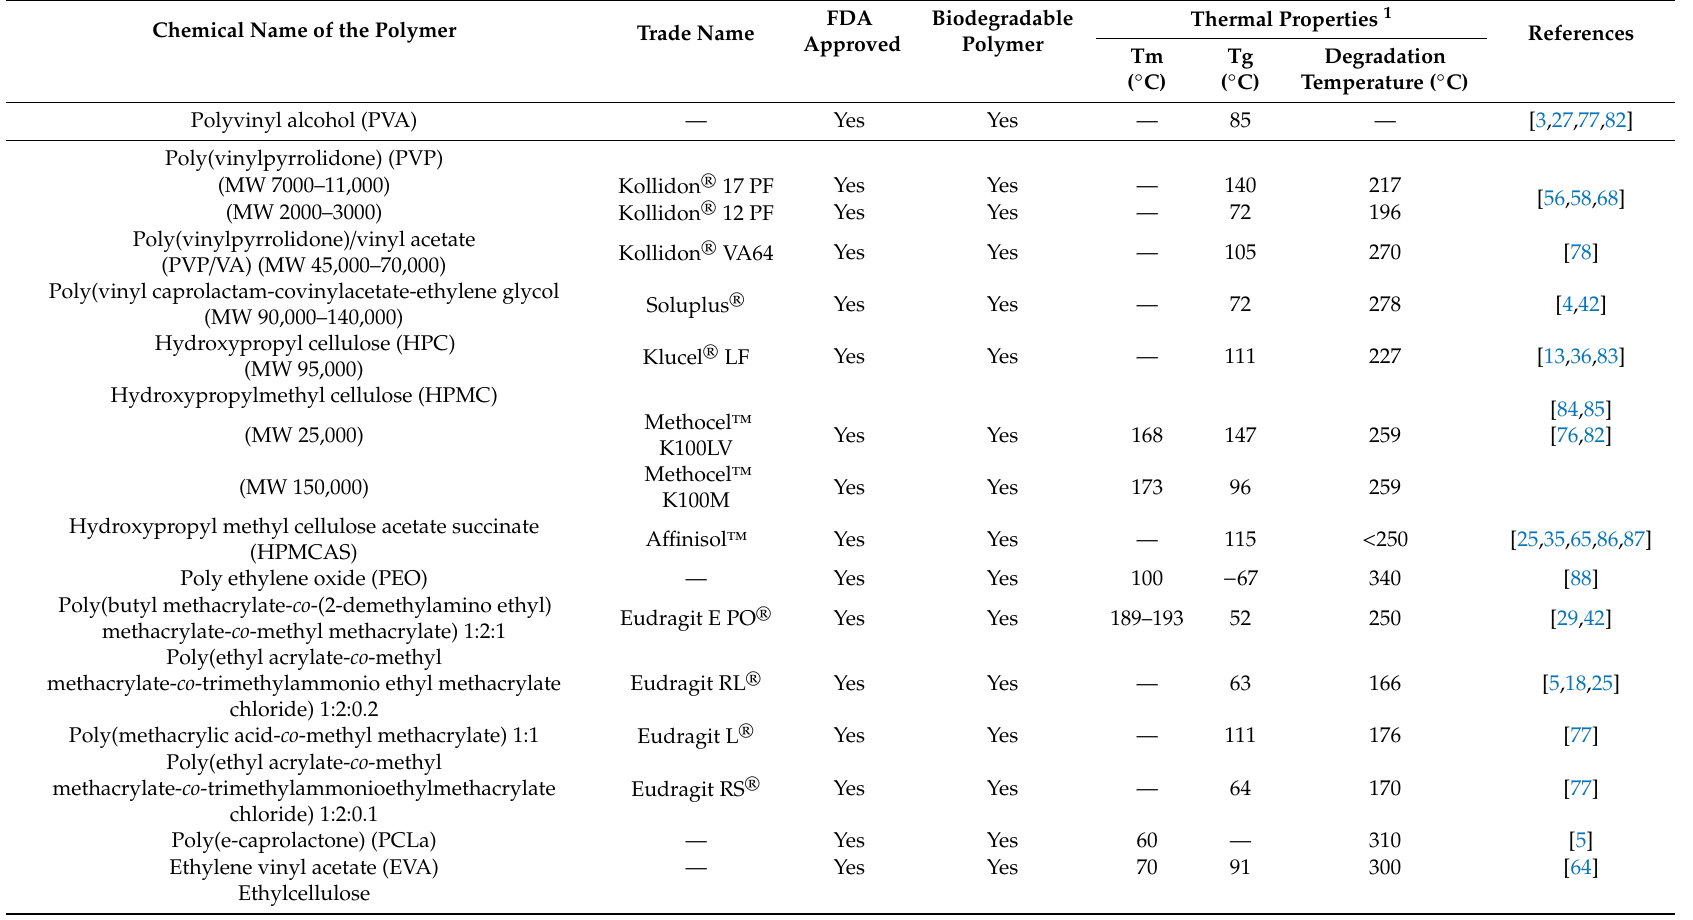
Table 2. Characteristics and thermal properties of the polymers used in hot-melt extrusion (HME)-coupled to FDM. Chemical Name of the Polymer